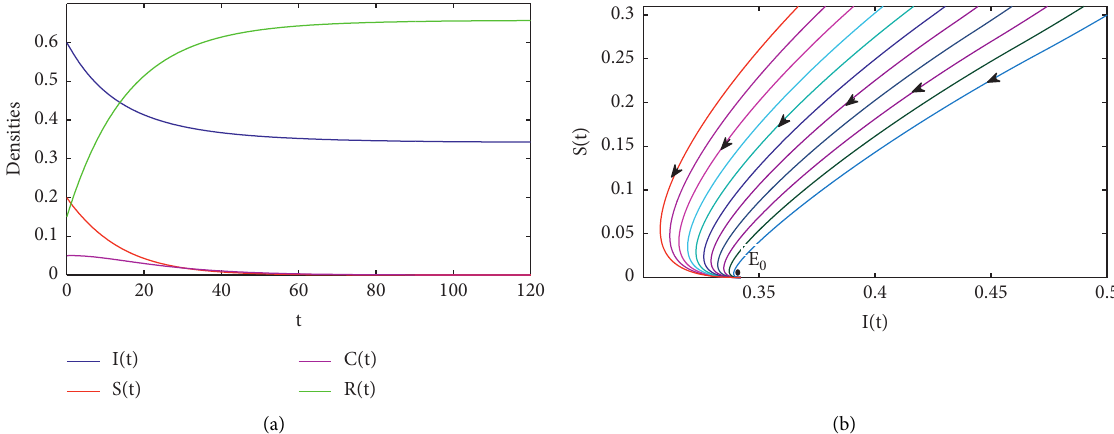
Figure 2: The stability of rumor-free equilibrium E